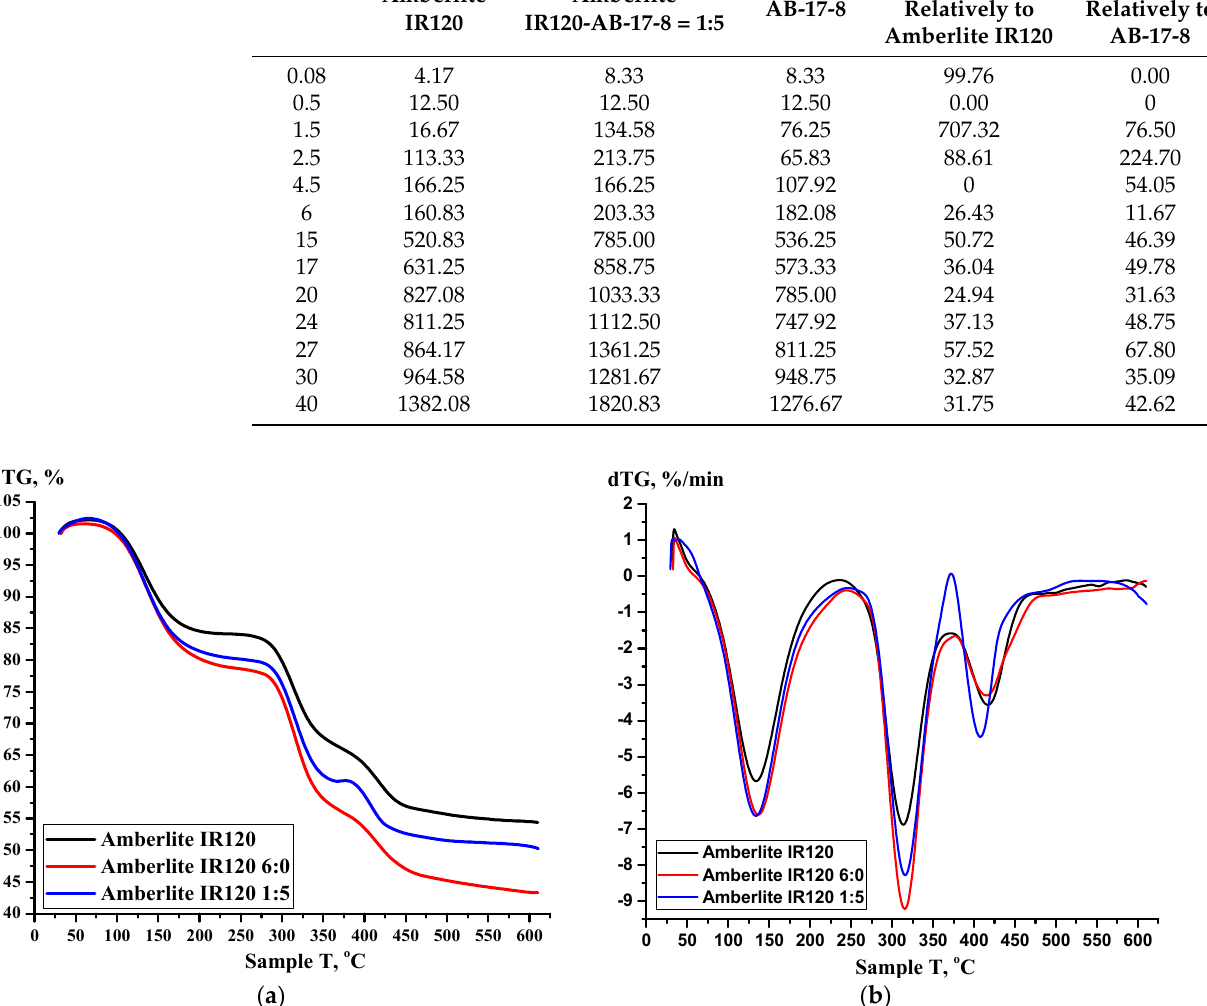
Figure 13. TGA curves of ( a ) mass loss and ( b ) rate of mass loss of Amberlite IR120. Figure 14 presents TGA curves of initial AB-17-8 (without sorbed europium), individual ion exchanger AB-17-8 with sorbed europium ions and AB-17-8 from ratio 1:5 with the sorbed metal ions from time of interaction 1.5 h. Figure 15 represents a comparison of thermal destruction curves (mass loss (a) and rate of mass loss (b)) of individual AB-17-8, AB-17-8 from ratio 6:0 and AB-17-8 from ratio 1:5. A difference in loss of mass of the 3 samples of AB-17-8 is observed from 200 ◦ C, before this temperature it occurs simultaneously. Strong mass loss from 375 ◦ C to 450 ◦ C points to thermal decomposition of the ion-exchange structure, differences in the values of the mass loss are due to sorption of europium ions by the macromolecule. The temperature area from 450 ◦ C to 625 ◦ C is accompanied with a slight decrease of the mass loss due to the stabilization of the thermal destruction